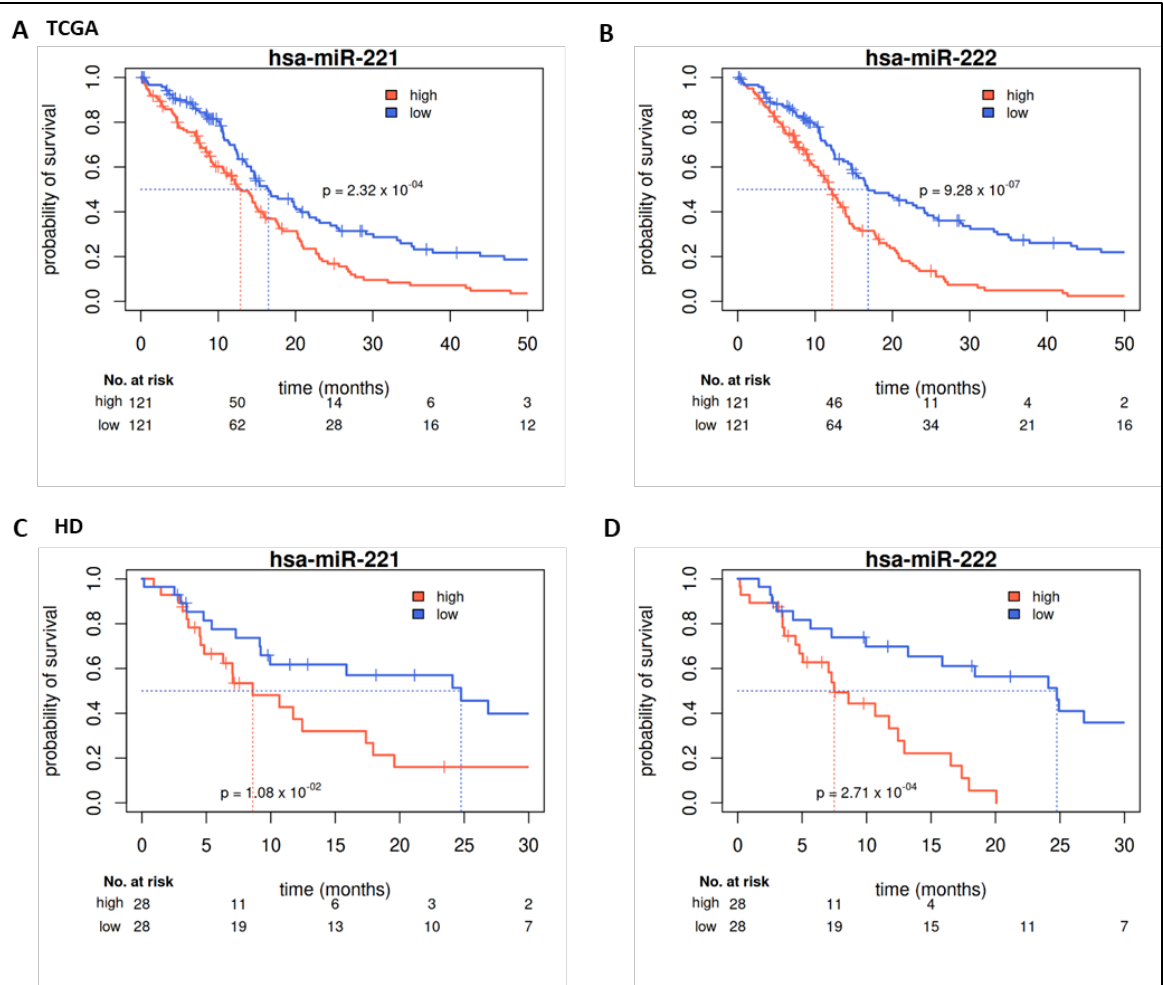
Figure 2. Prognostic value of miR-221 and miR-222. Kaplan–Meier survival curves for overall survival. High expression of miR-221 (( A ): TCGA; ( C ): HD) and miR-222 (( B ): TCGA, ( D ): HD) is associated with shorter OS in both cohorts. Median survival differences are 3.6 (16, HD cohort) months for miR-221 and 4.7 (17, HD cohort) months for miR-222 (Kaplan–Meier estimators and likelihood ratio test for groups of patients with expression below the first vs. above the third quar- tile).